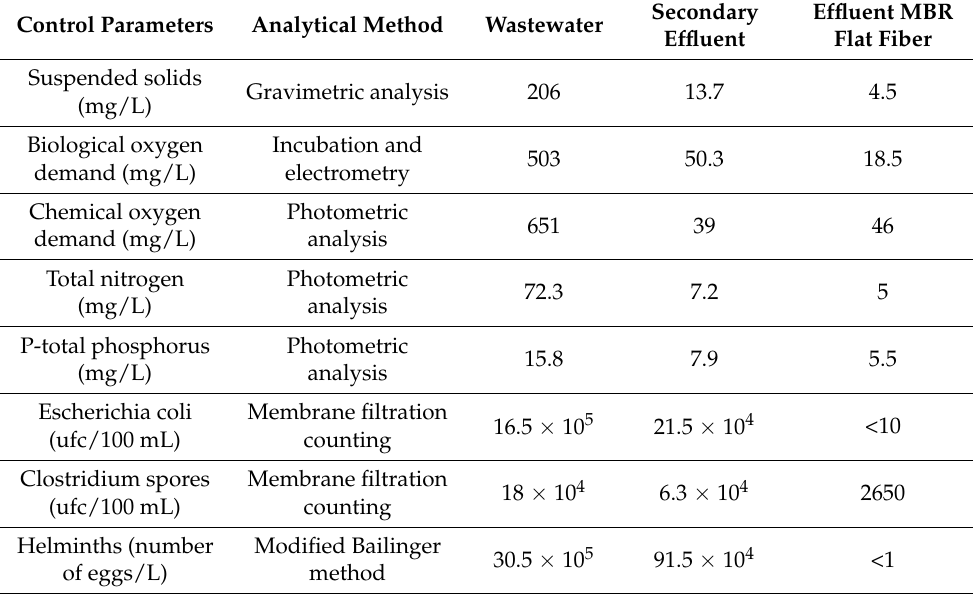
Table 3. Average concentrations of the usual parameters for treatment monitoring at WWTP